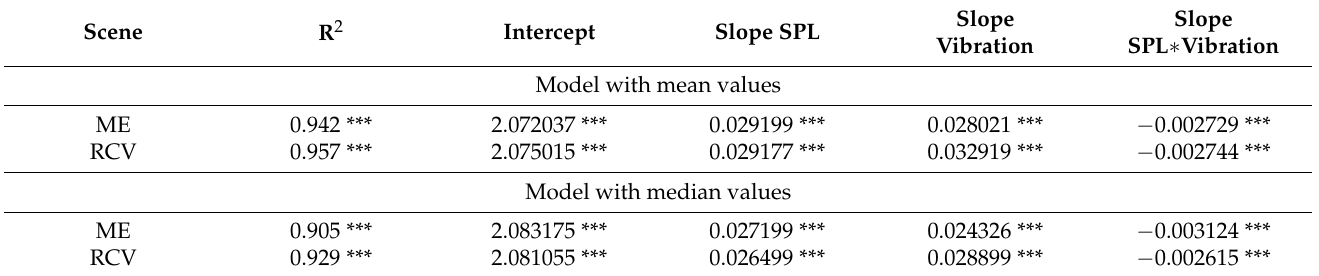
Table 3. Results of a linear multiple regression of the two main factors and their interaction term